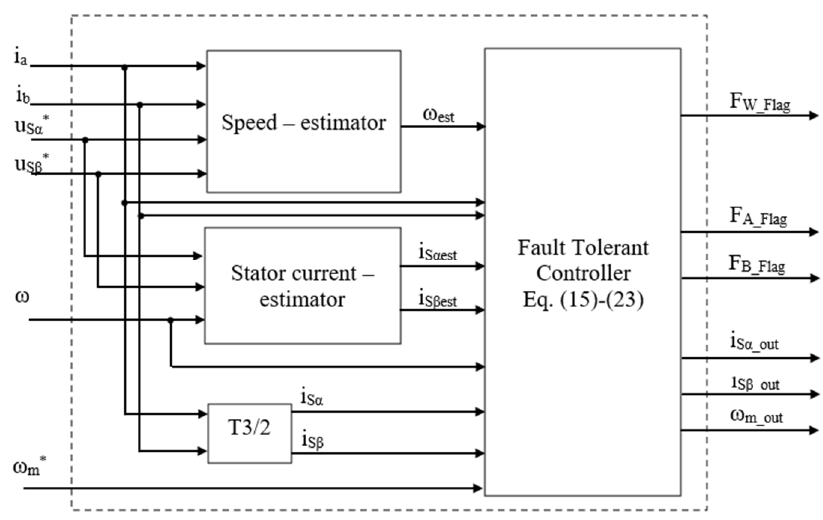
Figure 4. Block diagram of FTC unit (the symbol * means reference values).